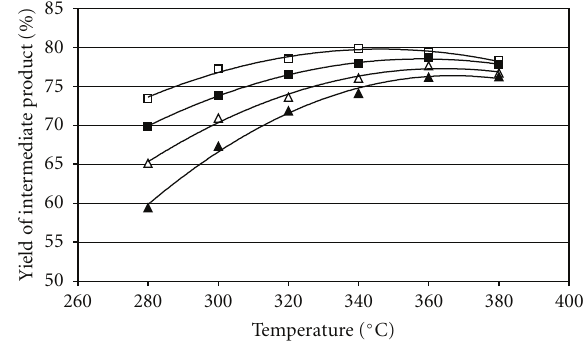
Figure 5: Yield of the INPRP as a function of the temperature -1.5 h − 1 , - and the pressure; where: (cid:3) (cid:0) 80 bar pressure (LHSV = 1.0h − 1 , H 2 /waste lard volume ratio = 600Nm 3 /m 3